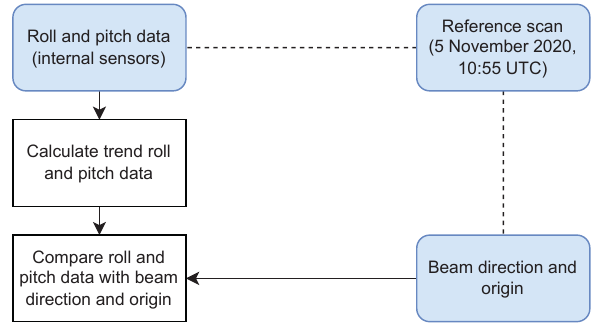
Figure 2. Flowchart with the approach to detect the origin of the radial stripes in the data.